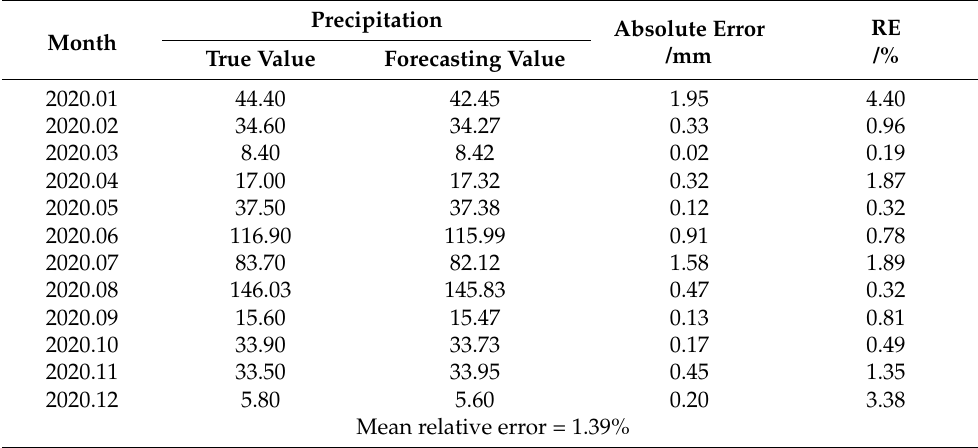
Figure 9. Prediction results of di ff erent models.